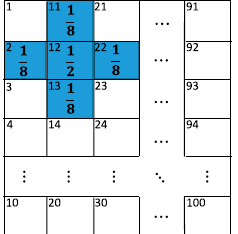
Figure 2. Illustration of a pixel grouping [23].